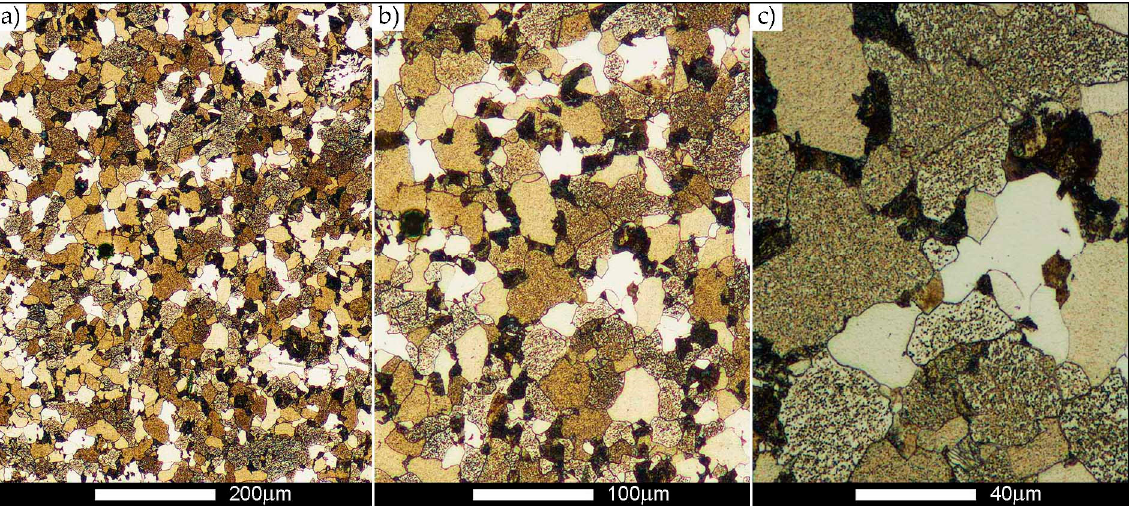
Figure 58. Welded joint microstructure of Hardox 450 steel in the normalised state with visible prior austenite grain boundaries—HAZ zone. ( a ) 100 × ; ( b ) 200 × ; ( c ) 500 × .